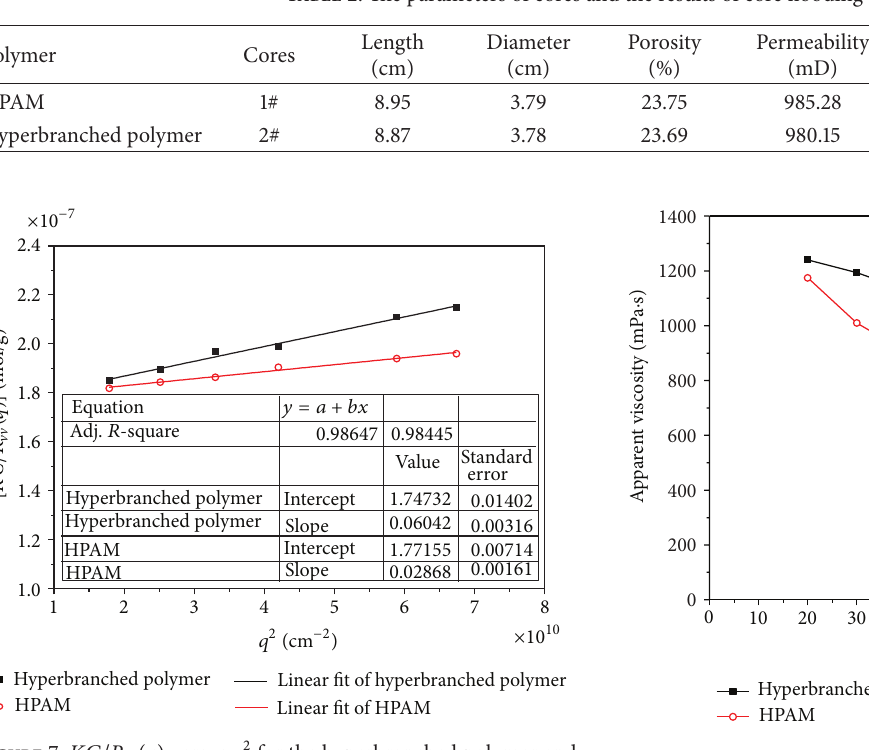
Figure 8: Apparent viscosity versus temperature for HPAM and hyperbranched polymer solutions (5000